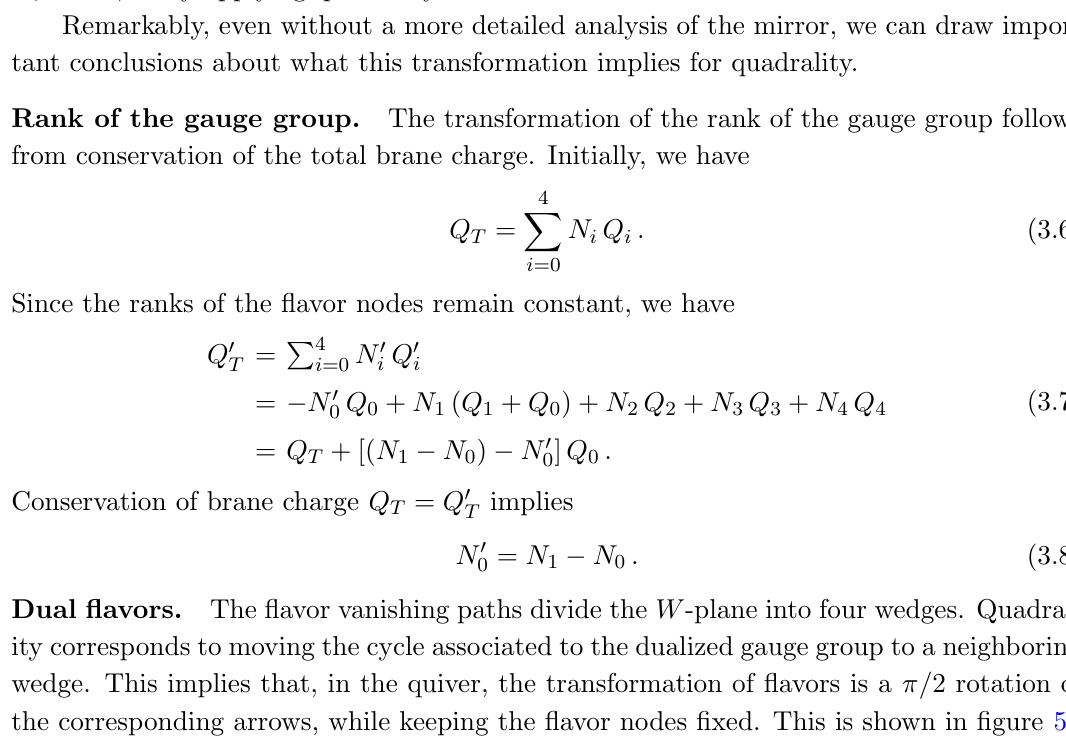
in the opposite direction to the wedge between 0